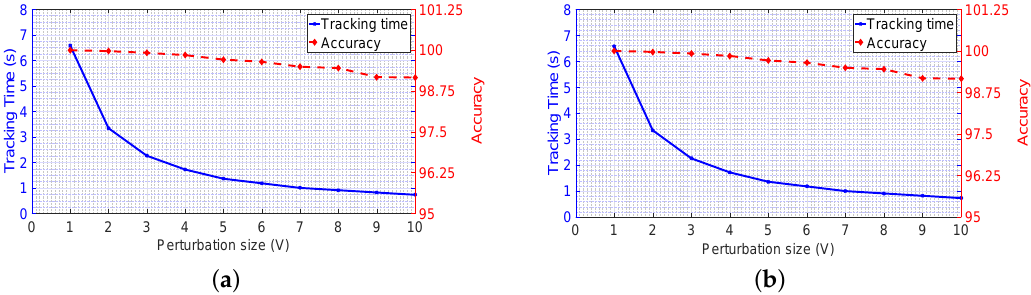
Figure 14. Efficiency and tracking time of various methods under various parameter calibrations.